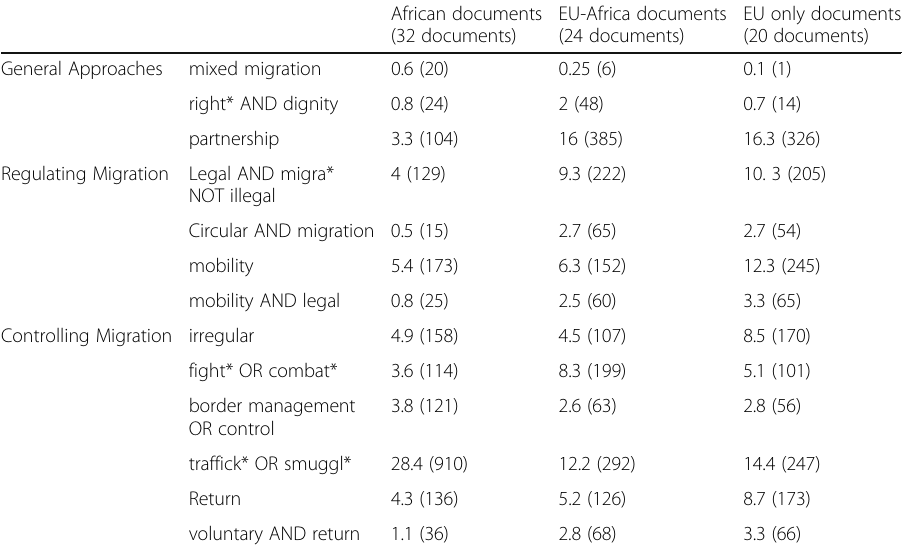
Table 2 Frequency counts for rhetoric on the different approaches to migration